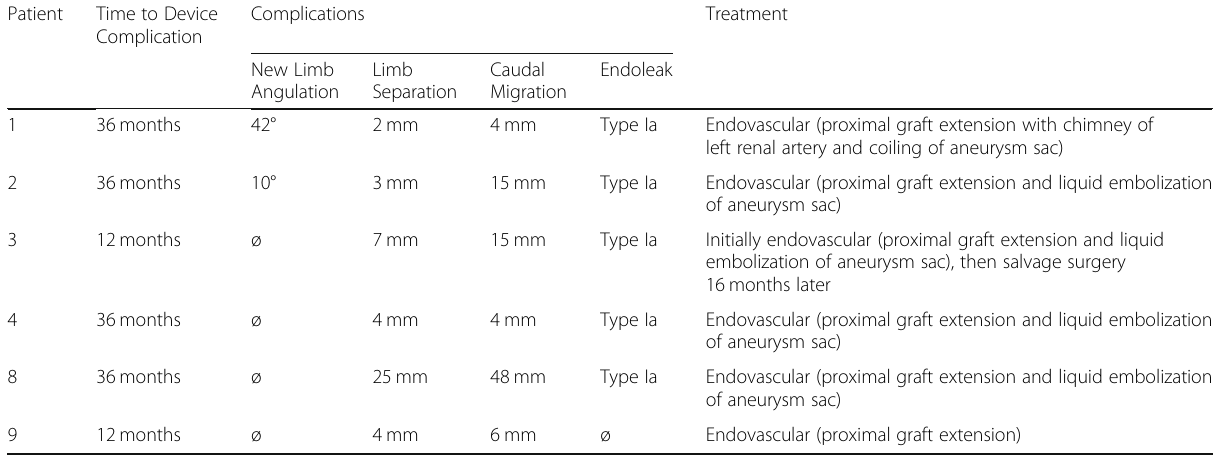
Table 2 Summary of complication characteristics and salvage interventions